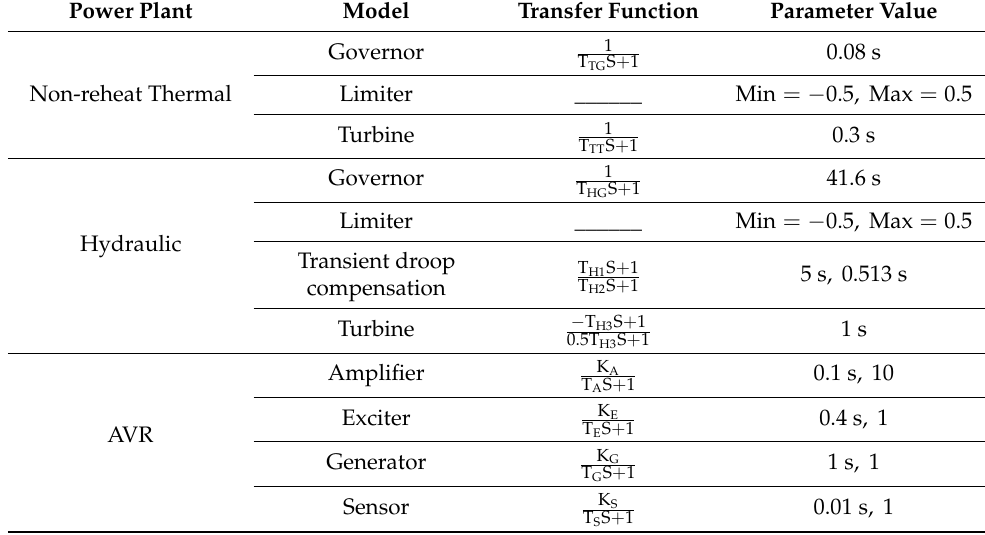
Table 1. The transfer functions presented in the investigated hybrid power system and their parame- ters’